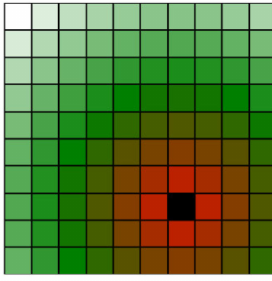
Figure 2. Simplified 2D visualization of position classification of voxels around an obstacle (the black voxel).